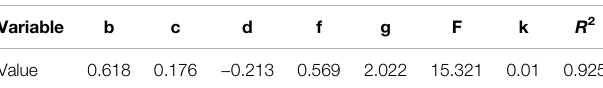
TABLE 3 | Ridge regression analysis